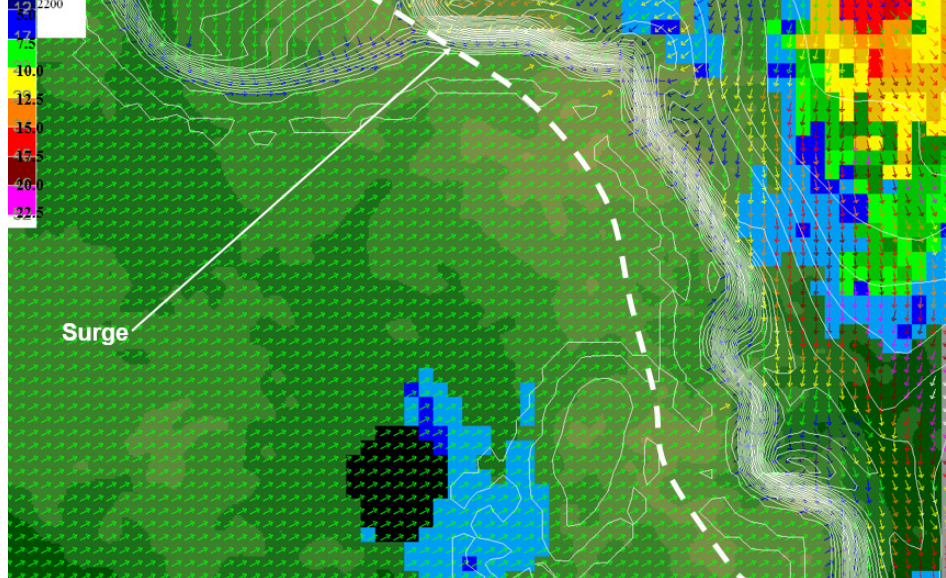
Figure 9. Gust front model derived wind field and temperature breaks showing locations and directions of movement of gust fronts near Yarnell, AZ at 1500 LST. Wind directions are shown by the arrows and relative speeds indicated by arrow colors.